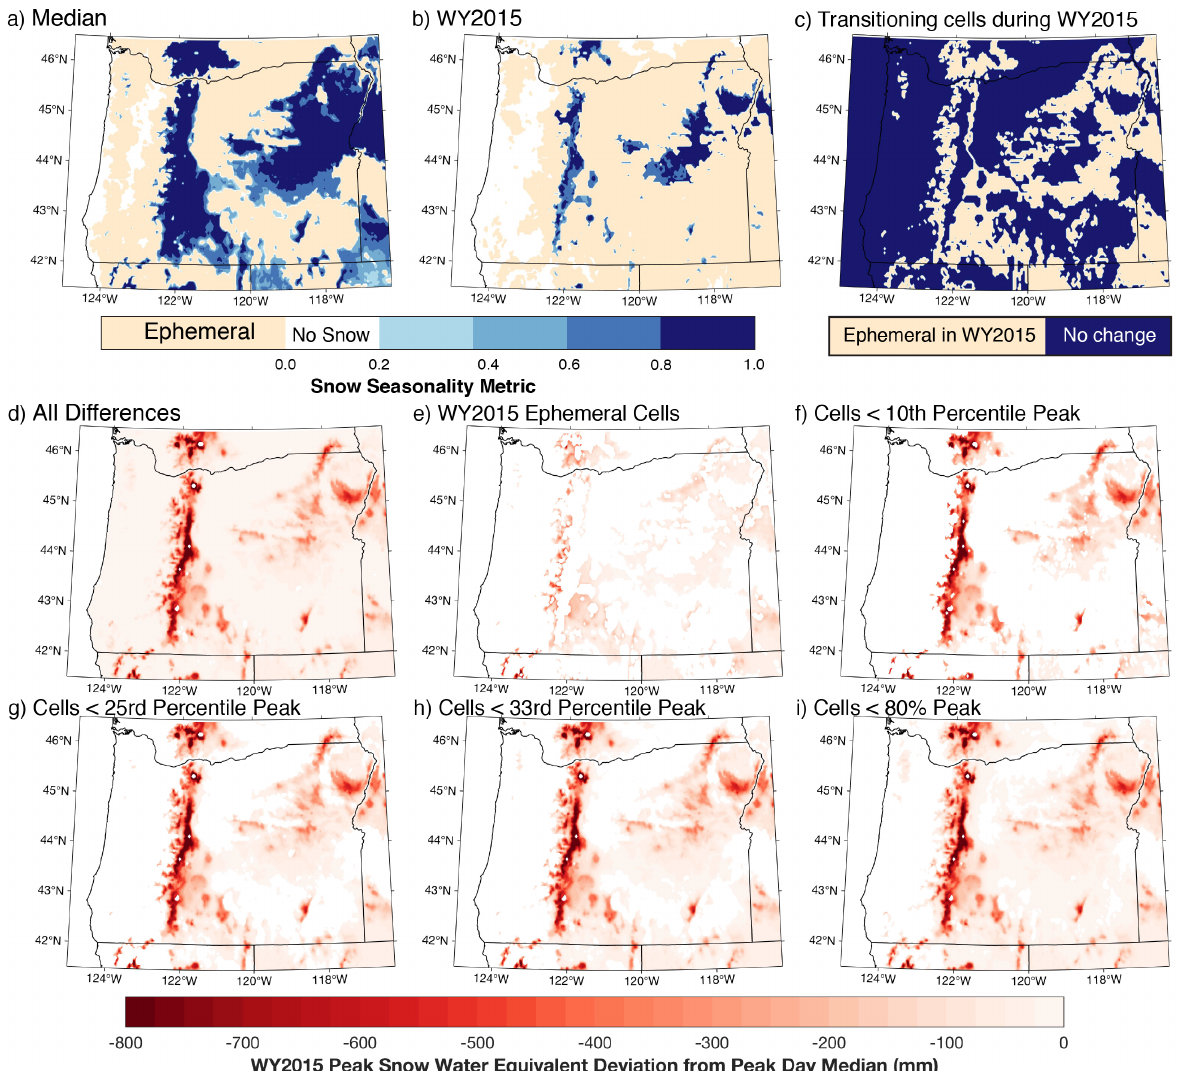
Figure 8. Example application of snow seasonality metric (SSM) to a snow drought year in Oregon. ( a ) Median SSM across all years; ( b ) SSM during water year (WY) 2015); ( c ) Cells that transitioned from seasonal to ephemeral in WY2015 are colored in tan; all other cells that remained seasonal or did not change are colored in blue. Deviations in peak WY2015 snow water equivalent (SWE; in mm ) from all year median values for ( d ) All cell differences; ( e ) Only ephemeral cells; ( f ) Cells with less than 10th percentile of peak SWE; ( g ) Cells with less than 25th percentile of peak SWE; ( h ) Cells with less than 33rd percentile of peak SWE; ( i ) Cells with less than 80% of average peak SWE (subjective criteria used to define snow drought by